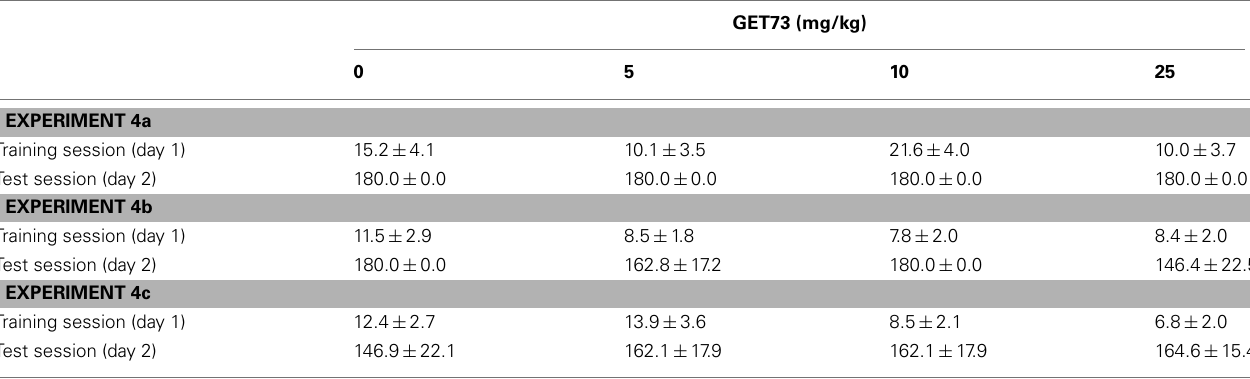
Table 2 | Effect of theacute, intraperitoneal administration of different doses of GET73 on latency of entry into the dark compartment in training and test sessions in Sprague-Dawley rats exposed to the PassiveAvoidance test.